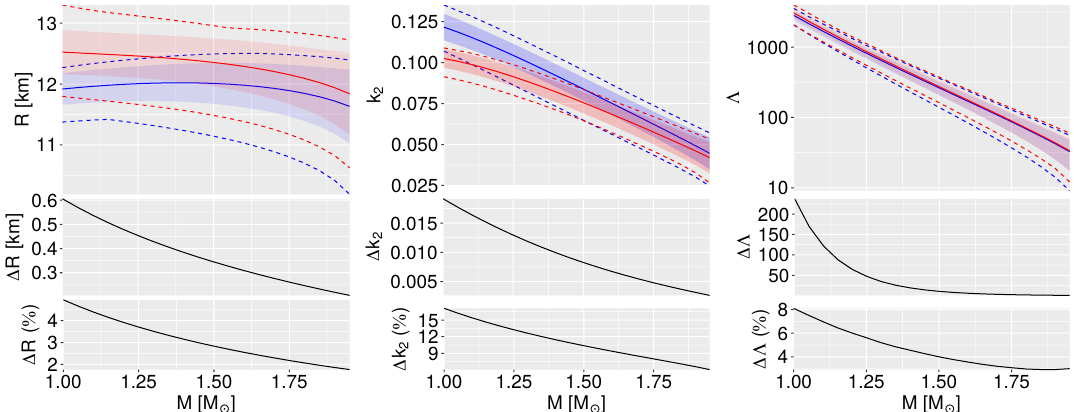
Figure 4. Top panels: Mean value (solid line), mean value ± 2 σ (filled region), and maximum/minimum values (dashed lines) for the NS radius ( left ), Love number k 2 ( center ), and Λ ( right ). The color identifies the matching procedure: Blue for P ( µ ) and red for P ( (cid:101) ) Middle panels: Difference between mean values, ∆ A = | ¯ A (cid:101) − ¯ A µ | , where A = { R , k 2 , Λ } . Bottom panels: Relative difference (%), defined by ∆ A = 100 × ( | ¯ A (cid:101) − ¯ A µ | ) / ¯ A , where ¯ A = ( ¯ A (cid:101) + ¯ A µ ) /2. The difference on the average predictions decreases as more massive NSs are